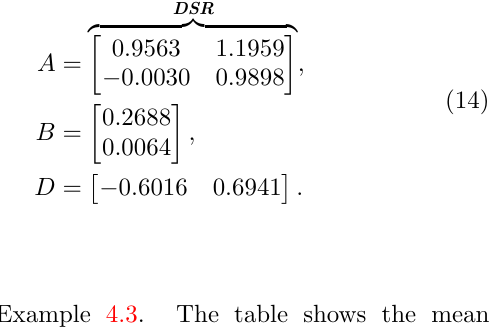
ment and Table 4 (rows 2:3, columns 4:5) for the cor- responding performance and input usage indices.